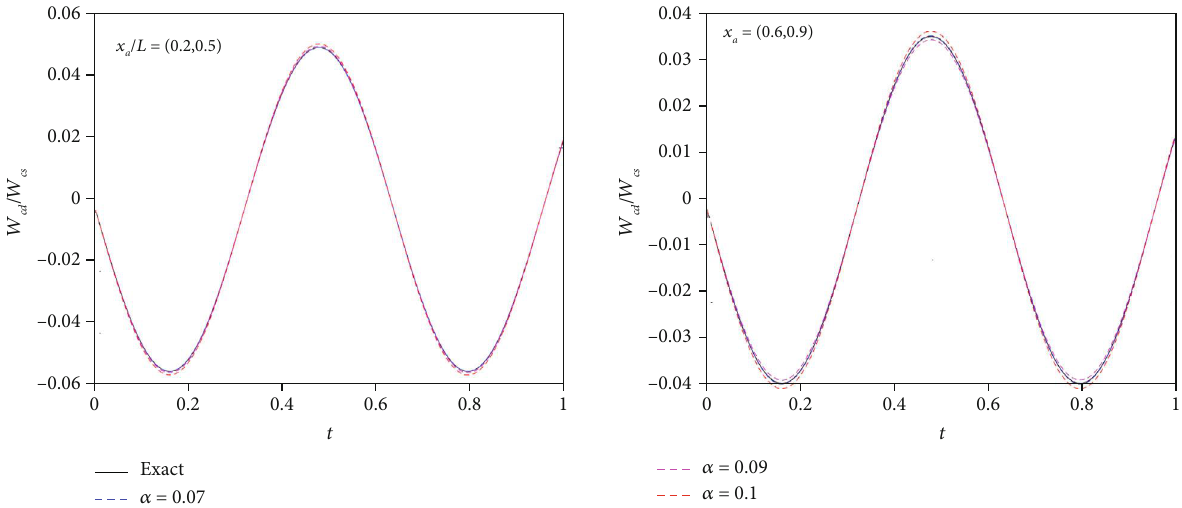
Figure 7: Convergence and accuracy of the numerical results for di ff erent values of α for the case where the dimensionless di ff erential equation of motion of the beam is discretized using the DQM ( n = 31